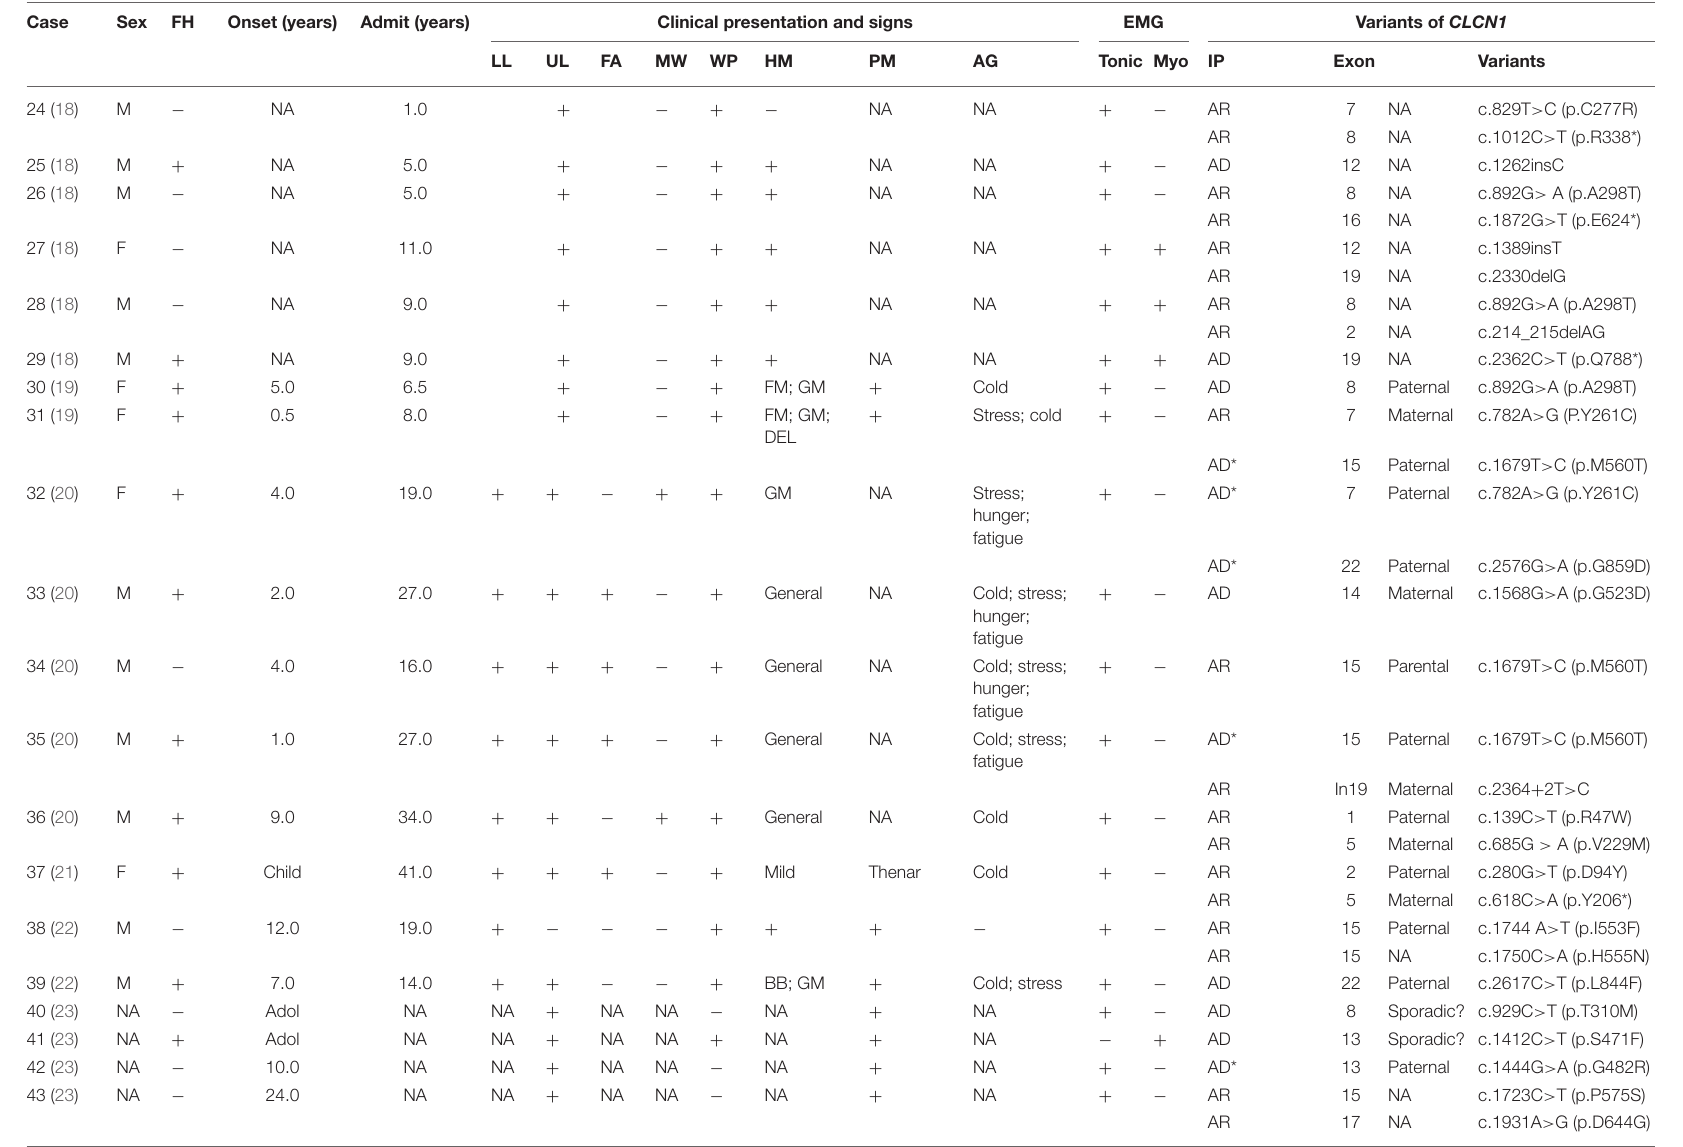
musculus biceps brachii; GM, gastrocnemius; FM, forearm muscle; SGM, the shoulder girdle muscles; DEL, deltoid muscle. AD * , automatic dominant with incomplete penetrance (which has been provided in Table 1 ). ?, possible inheritance pattern (genetic results of parents not available); bold, novel variants found in our 5